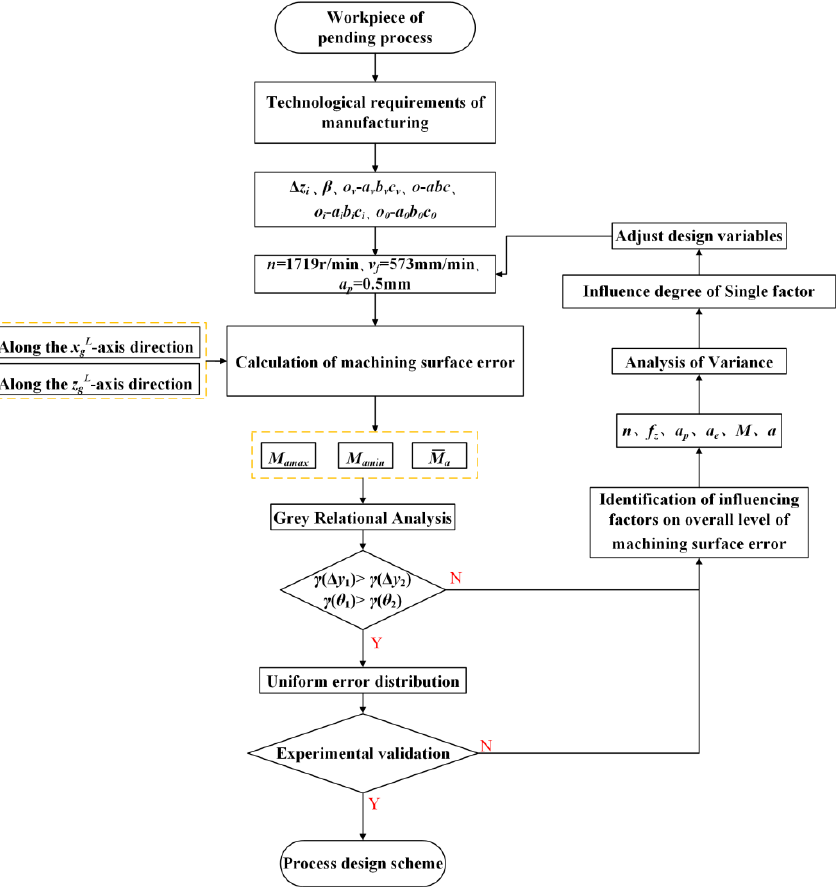
Figure 13. Process design method for consistency of milling error distribution.